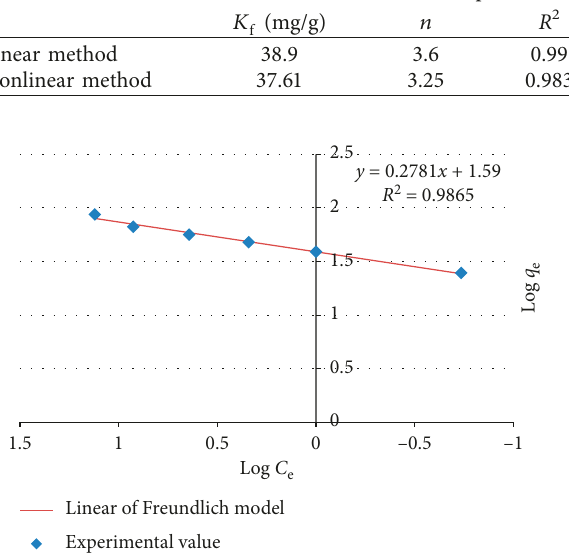
Table 4: Nonlinear and linear Freundlich and Langmuir constants for the adsorption isotherm of RB on Fe Freundlich parameters Langmuir parameters